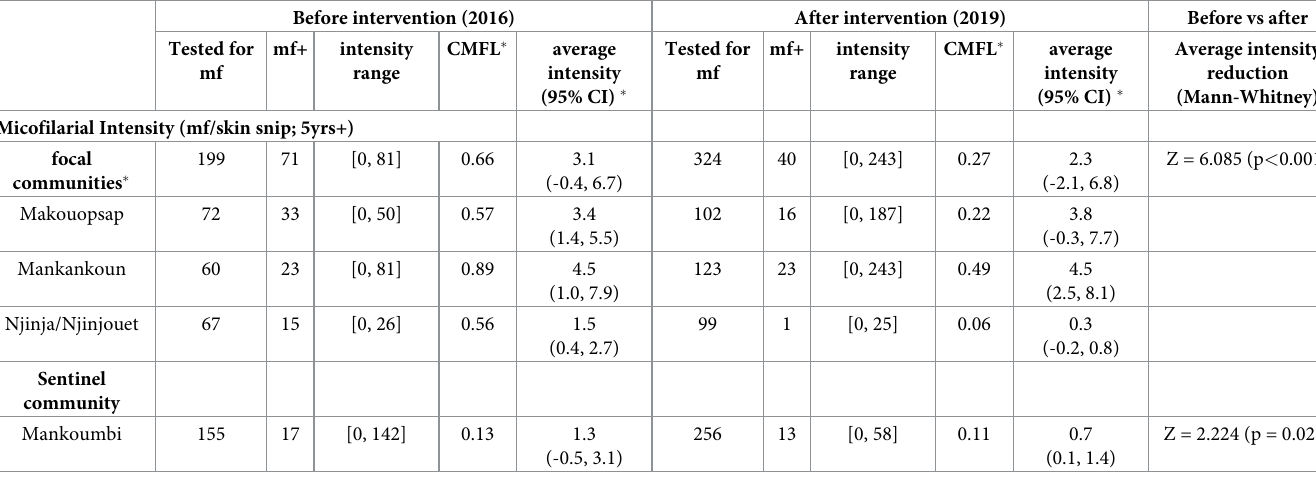
Table 7. Comparing mf intensity across the surveys.